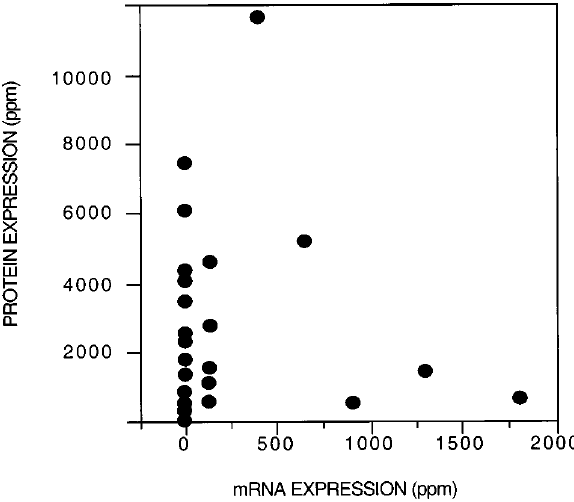
Fig. 5. Relationship between protein and mRNA expression levels of a number of genes expressed in prostate carcinomas. On the y -axis, the protein expression levels are plotted (as ppm of totally loaded protein on 2-DE gels, average of 6 gels from prostate carcinoma). On the x - axis, the representation of the same gene products in cDNA libraries are plotted (as ppm, number of hits per 7747 cDNA clones in 3 prostate carcinoma libraries). is available at the web-site